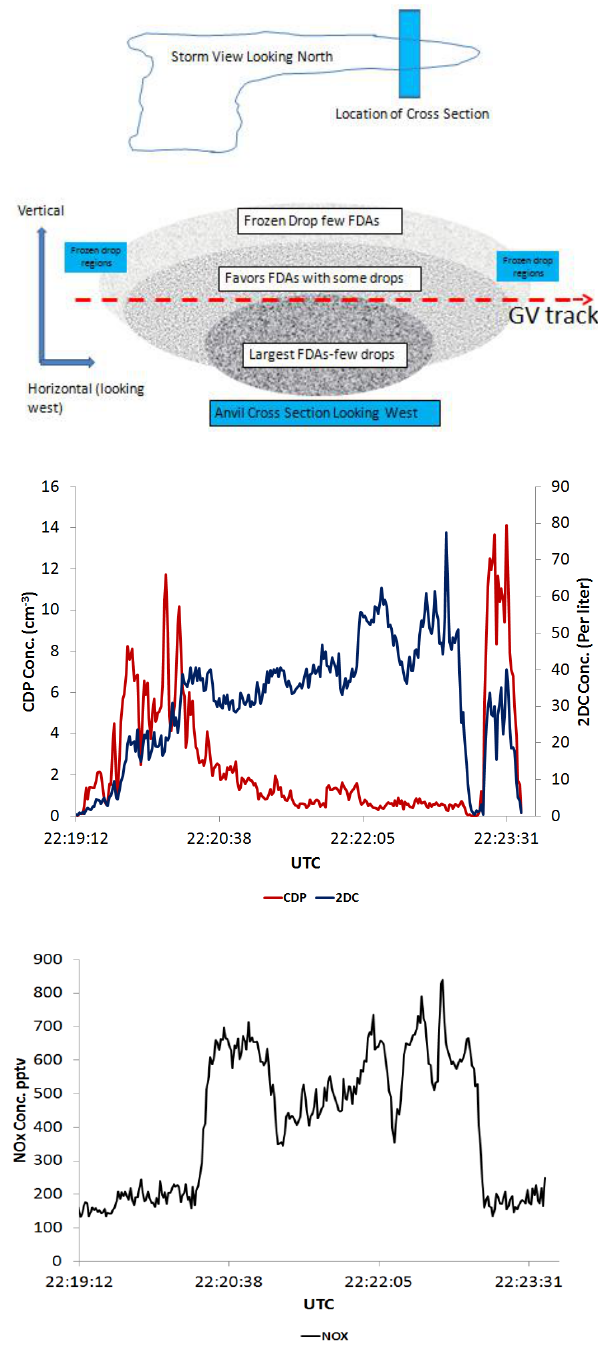
Figure 4. Schematic of the storm anvil in cross section on 6 June 2012 showing cross section of frozen drops and FDAs to- gether with track of the G-V (top), CDP concentrations, and 2DC concentration during pass across the anvil at a temperature of ap- proximately − 57 ◦ C (middle), NO x concentrations during the pass (bottom). (Top and middle figures adapted from Stith et al., 2014).